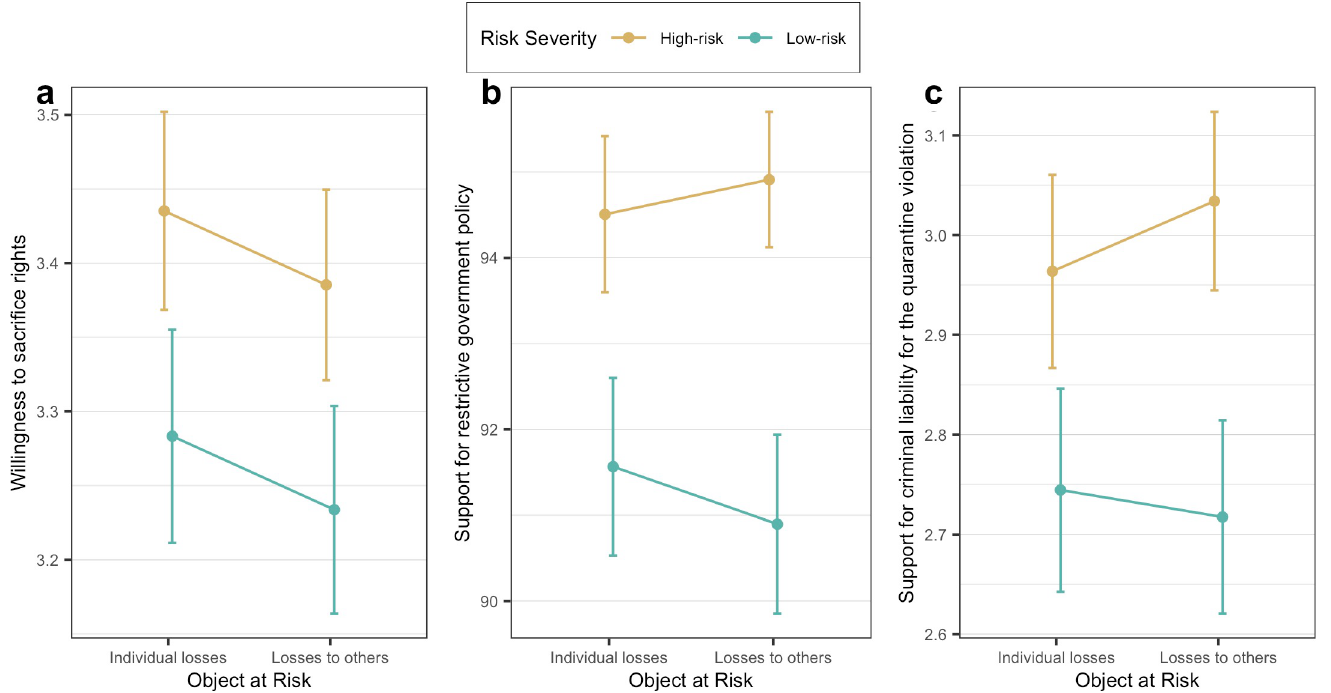
Fig 1. From left to right, the group means with 95% error bars in a) the willingness to sacrifice rights, b) the support for restrictive government policy, and c) the support for criminal liability for quarantine violation.